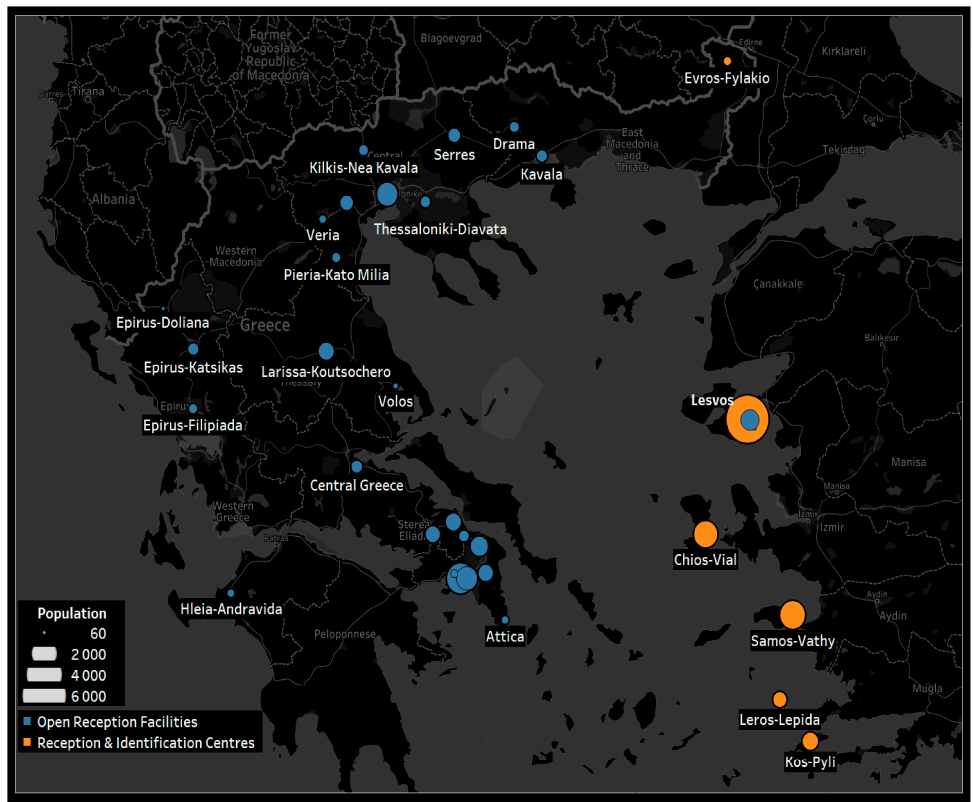
Figure 1. The main reception centers in Greece. Chios, Kos, Lesvos, Leros, Samos, and other Greek islands are rapidly and easily accessible points of entry into Europe. Notes: The orange circles represent the main reception and identification centers in Greek islands; the blue circles represent the open reception facilities (hotspots) on the mainland. The area of the circle depicts the size of the refugee population.